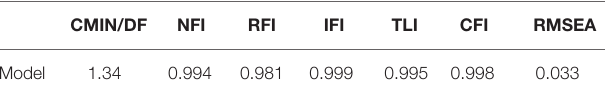
TABLE 3 | Model fit indexes of the mediation analysis in the predominantly positive situation.